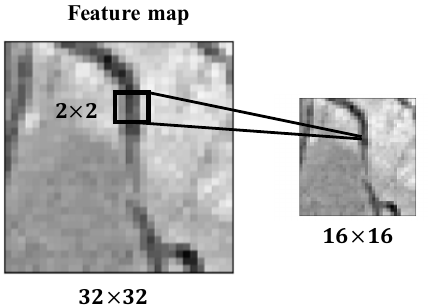
Figure 3. Operation of max-pooling layer block. A 2 × 2 max-pooling operation follows the 32 × 32 K feature maps. The stride parameter was fixed to 1.